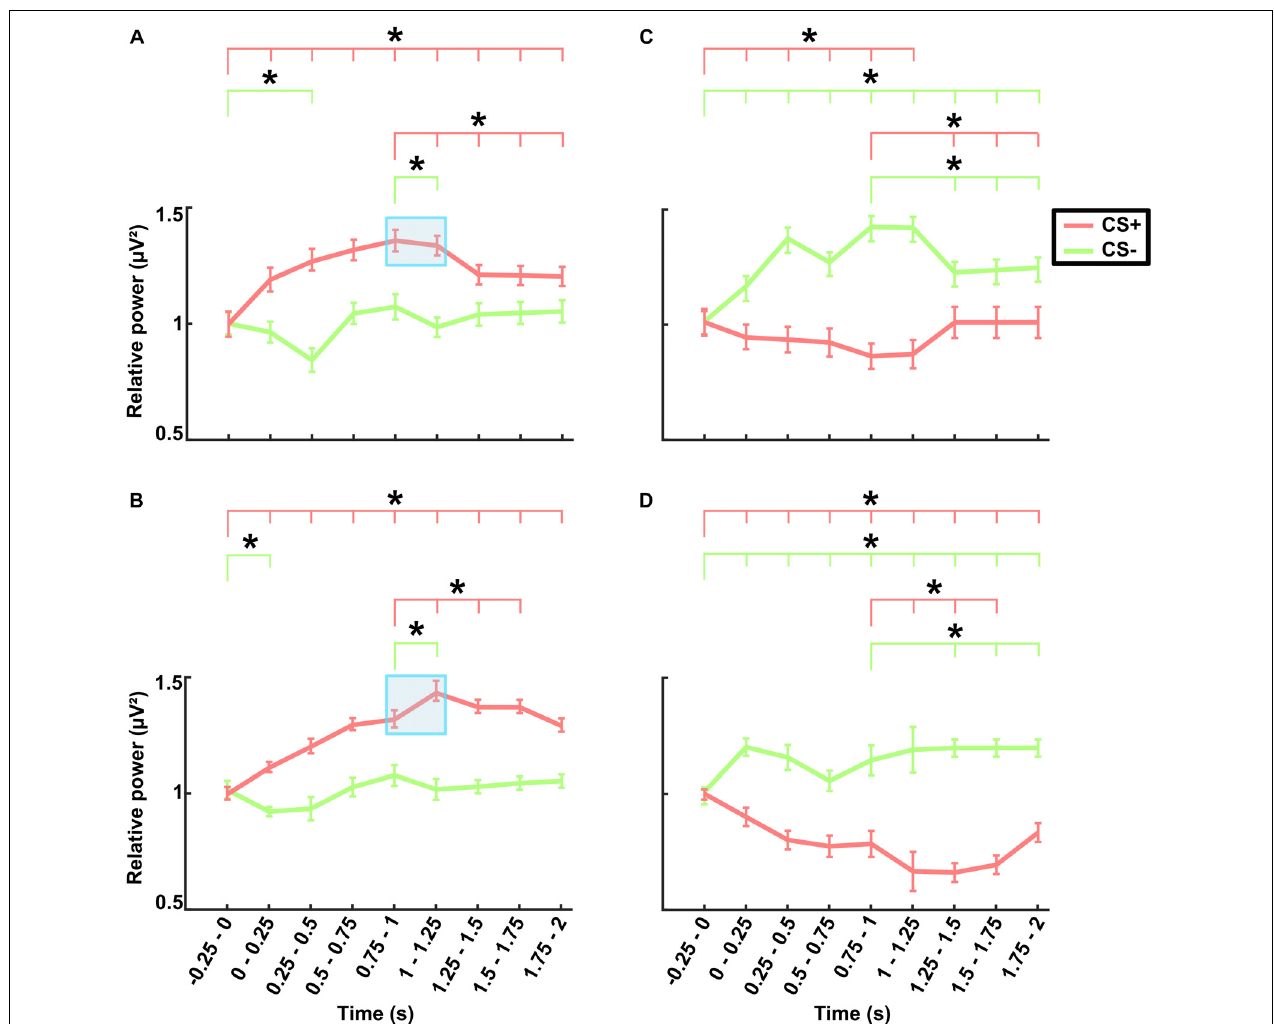
FIGURE 5 | Electroencephalography power averaged across frontal electrodes (shown in Supplementary Figure 1 ) in the theta band for (A) the no-TMS experiment and (B) the TMS experiment. The power averaged across occipital electrodes (shown in Supplementary Figure 1 ) in the alpha band for (C) the no-TMS experiment and (D) the TMS experiment. The values are mean ± standard error of the mean. The light red bar represents CS+ and light green denotes CS–. The asterisk ( ∗ ) denotes significant differences after correcting for multiple comparisons ( p < 0.05, Bonferroni